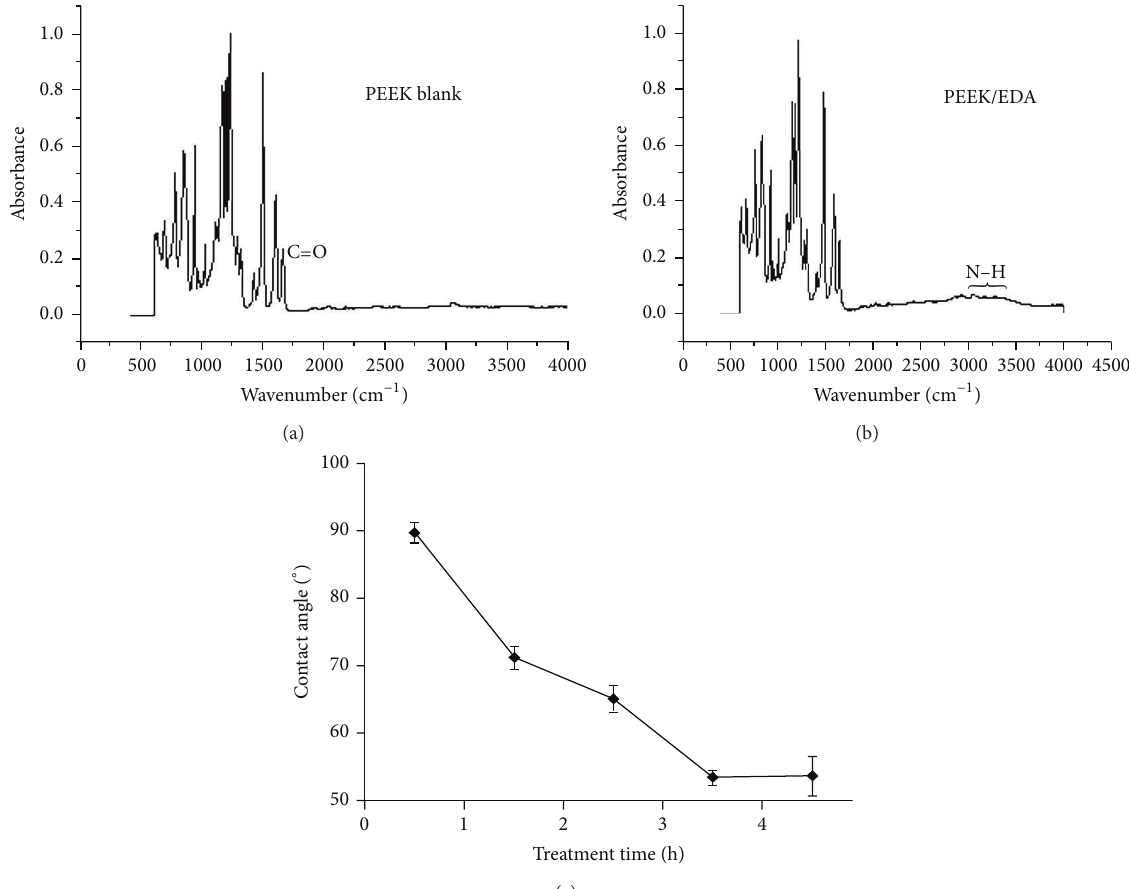
(c) Figure 2: ATR-FTIR and contact angle measurement. As a consequence of the diamine treatment a signal emerged around 3400 cm −1 suggesting the formation of amino moieties (b) that is not present on unmodified material (a). Due to extensive hydrogen bonding this peak is extremely broadened. Wettability increases in the course of treatment time (c) and reaches a maximum after 3 h indicating a maximum of surface modification.